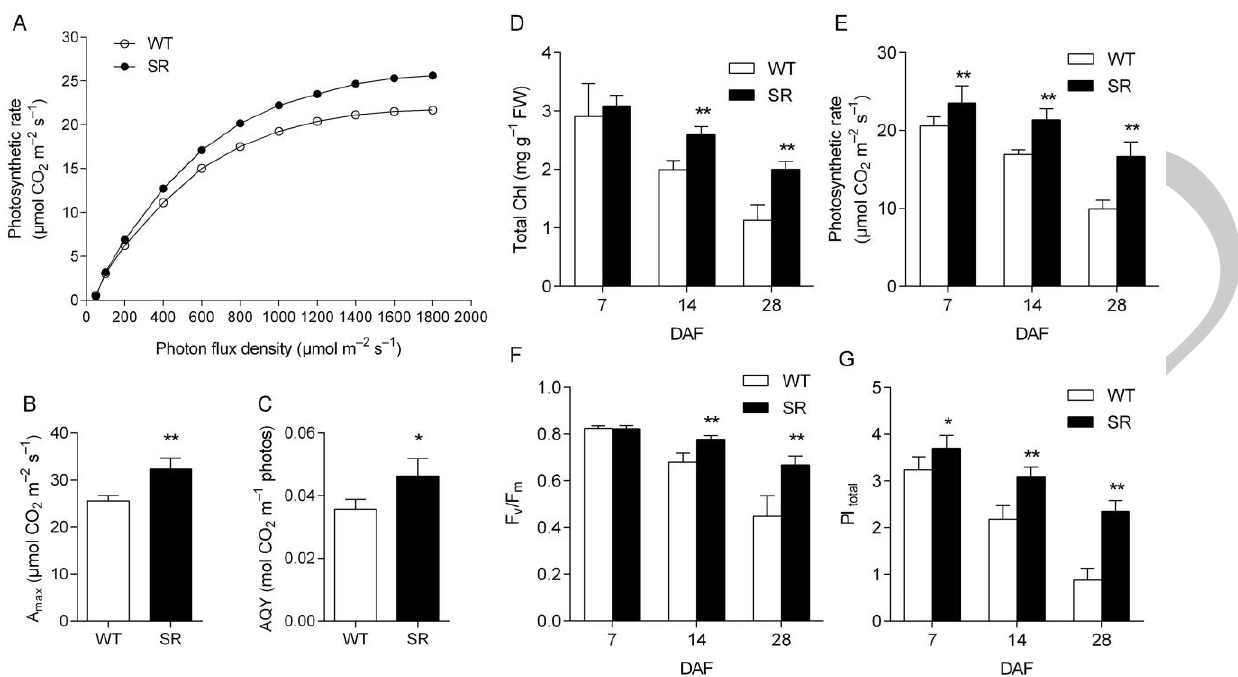
Figure 4. SR exhibits a higher rate of photosynthesis than WT. ( A ) Light-response curves of flag leaves in WT and SR were generated at 7 DAF at a temperature of 30 °C under normal air conditions. ( B , C ) A max (light-saturated photosynthetic rate) and AQY (apparent quantum yield) of flag leaves in WT and SR were calculated from the light-response curves. ( D ) Total Chl level of flag leaves in WT and SR. FW, fresh weight. ( E ) Photosynthetic rates of WT and SR. Flag leaves were consistently measured under normal air conditions. ( F , G ) F v /F m (maximal PSII quantum efficiency) and PI total (total performance index) of flag leaves in WT and SR. Values ( B , C ) are given as means ± SD ( n = 3). Value ( D ) is given as mean ± SD ( n ≥ 6). Values ( E – G ) are given as means ± SD ( n ≥ 6). Asterisks indicate significant differences between WT and SR. * p < 0.05; ** p < 0.01 compared with WT by Student’s t -test.